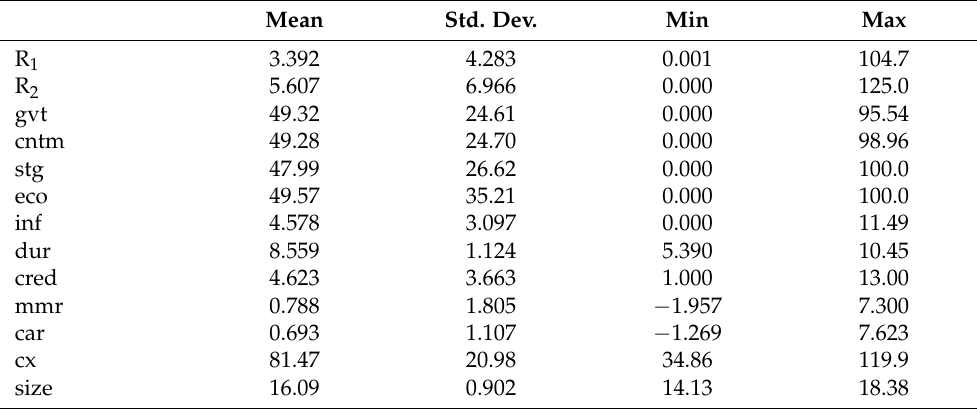
Table 1. Summary